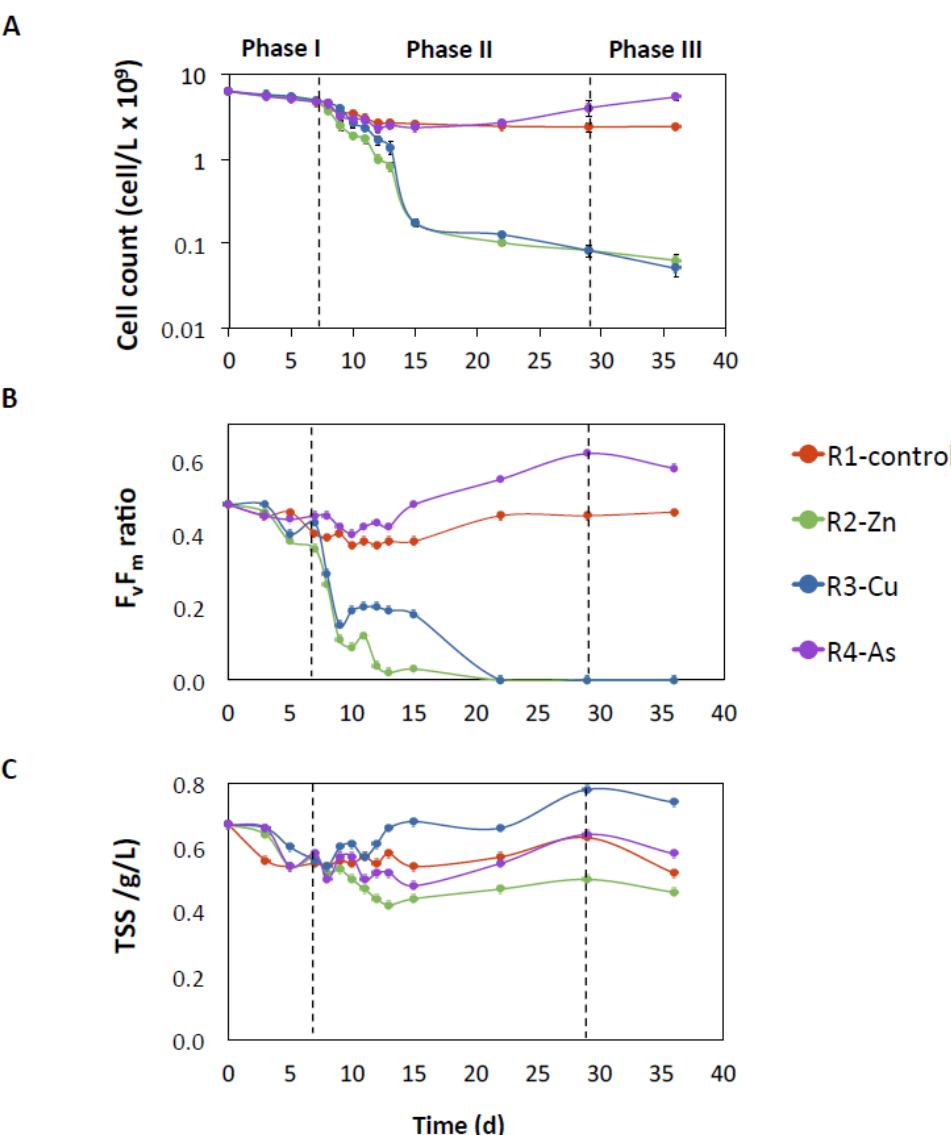
Figure 2. Microalgae growth parameters for the sets of experiment B. Cell count ( A ), maximum quantum yield of PSII by F v /F m ratio ( B ), and TSS ( C ) in the R1-control, R2-Zn, R3-Cu, and R4-As PBRs. Horizontal dashed lines indicate the change of operational phase.